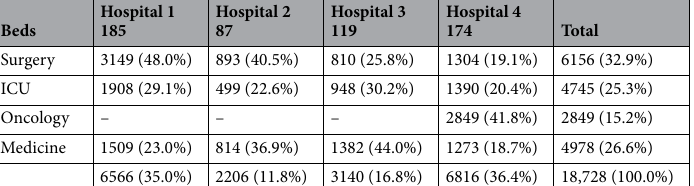
Table 1. Counts and relative frequencies of red blood cells transfusions across hospitals (columns) and medical specialties (rows) during the observation